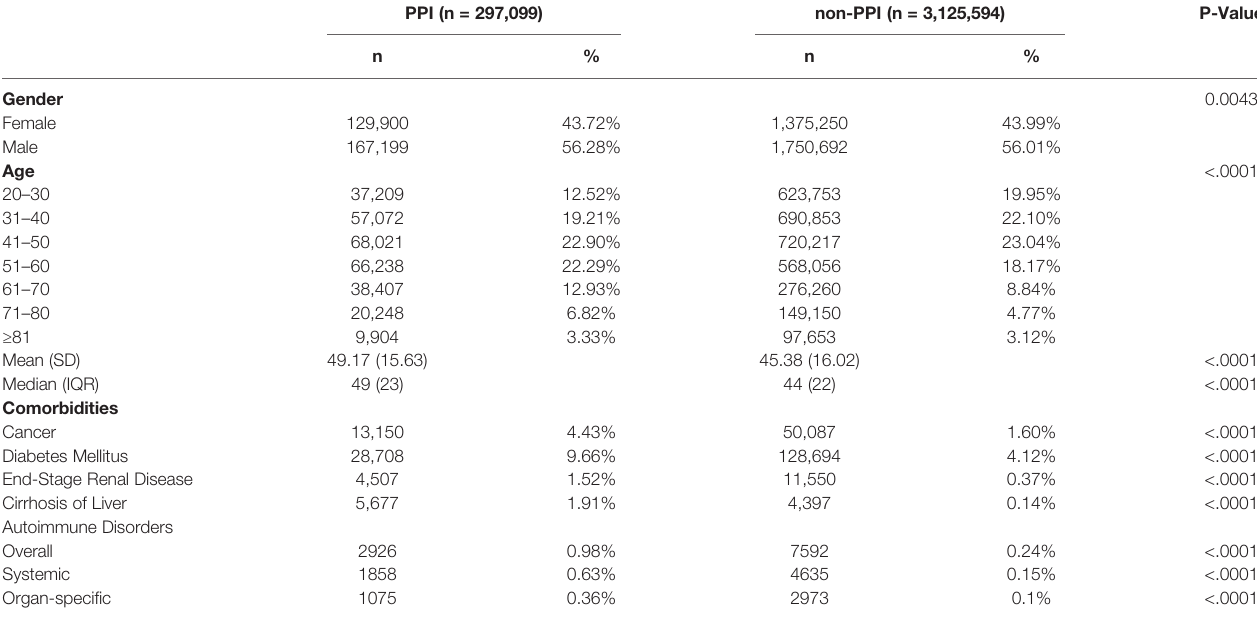
TABLE 1 | Baseline characteristic of PPI and non-PPI users.